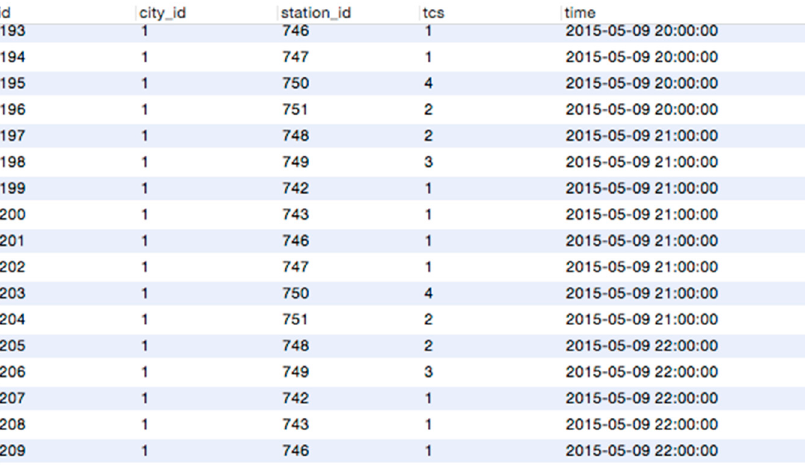
Figure 8. Traffic congestion status.